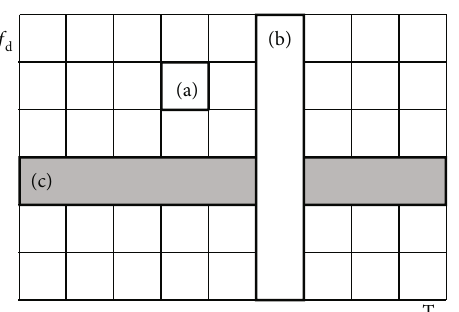
Figure 7: GPS signal acquisition methods. Single search step for (a) serial, (b) parallel in Doppler frequency, and (c) parallel in code delay approaches.